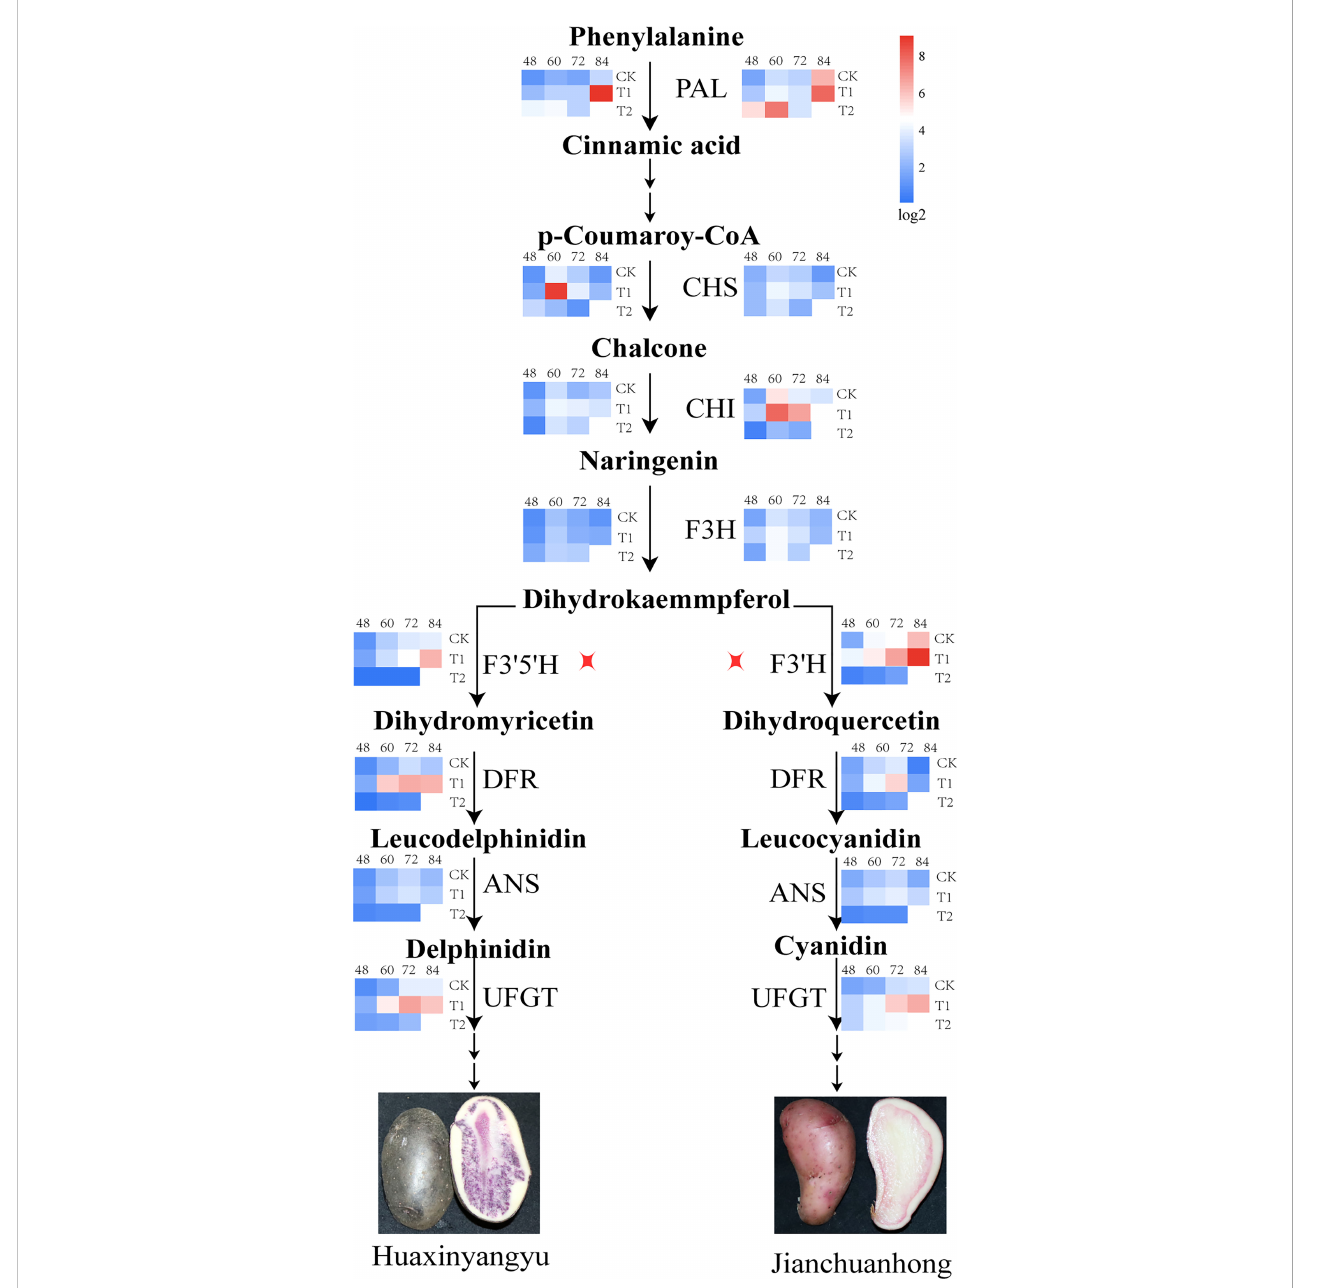
FIGURE 6 Impacts of increased different UV-B exposure on Structural Genes of Anthocyanin Synthesis Pathway in Tuber (CK, T1, and T2 were treated with different UV-B treatments, and 48, 60, 72 and 84 were the different growth stages of “ Huaxinyangyu ” and “ Jianchuanhong ” ). PAL, phenylalnine ammonialyase; CHS, chalcone synthase; CHI, chalcone isomerase; F3H, fl avanone 3-hydroxylase; F3 ’ 5 ’ H, fl avanone 3 ′ ,5 ′ -hydroxylase; F3 ’ H, fl avanone 3 ′ -hydroxylase; DFR, dihydro fl avonol 4-reductase; ANS, anthocyanin synthetase; UFGT, UDP glucose- fl avonoid 3-O-glucosyltransferase. According to the Duncan test, different letters indicate a signi fi cant difference (p< 0.05) among the treatments. The error bars represent the mean ±